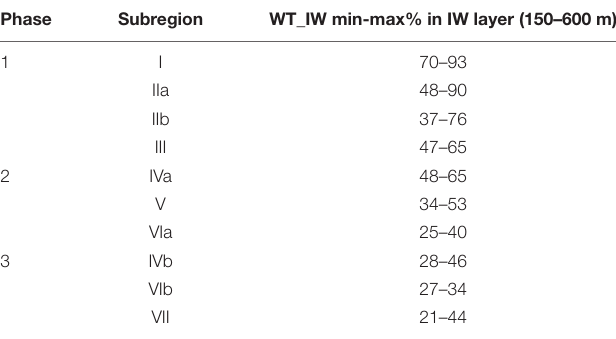
TABLE 4 | Range of the mixing fractions (%) of WT_IW (as defined in Table 1 ) within the layer 150–600 m (values shown in Figure 2B ) estimated by the OMP analysis, during the different phases of IW